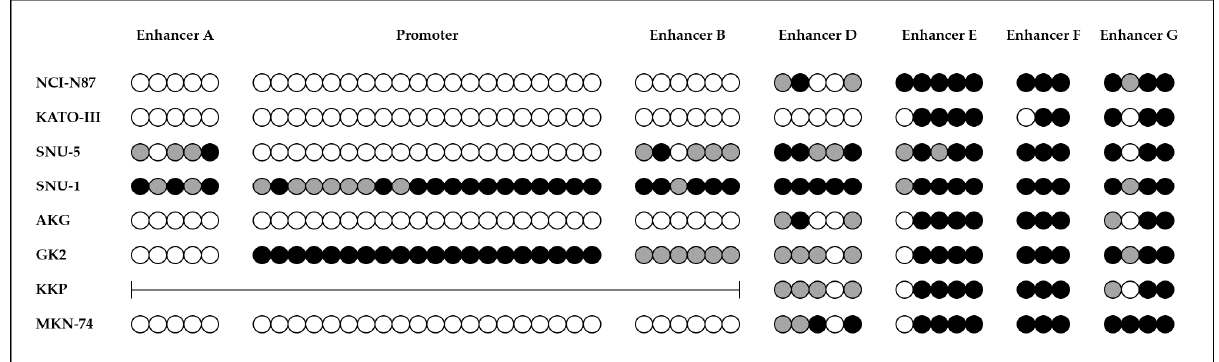
Figure 2. Methylation status of CDH1 promoter and enhancers of eight GC cell lines expressing different levels of CDH1 . non-methylated CpG site; fully methylated CpG site;